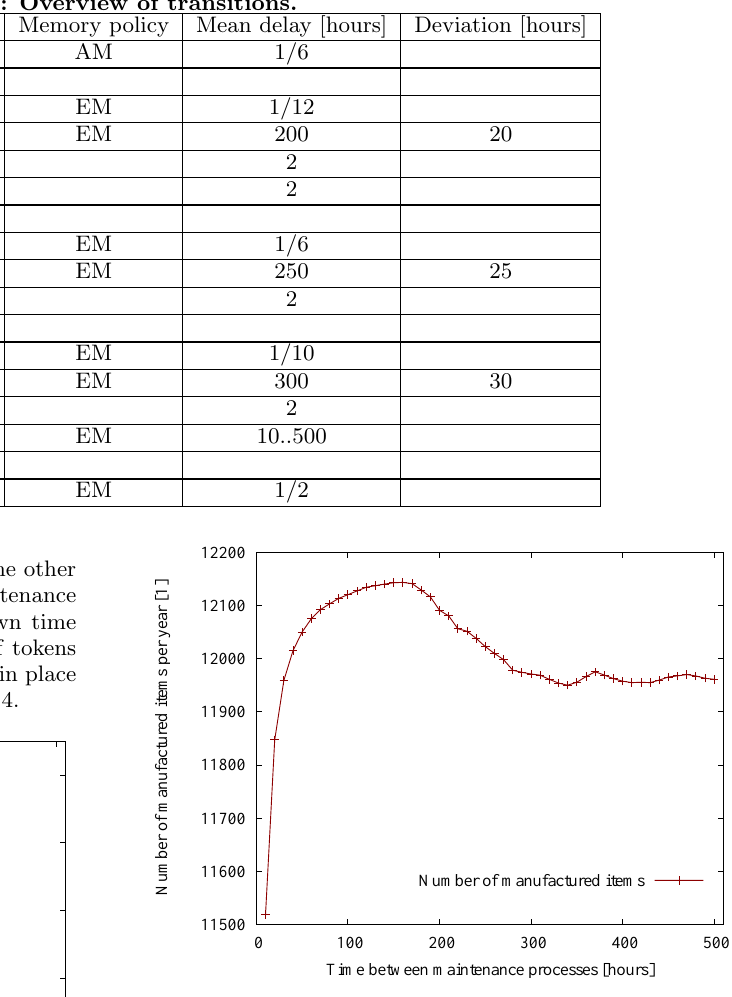
Figure 5: The number of manufactured items per